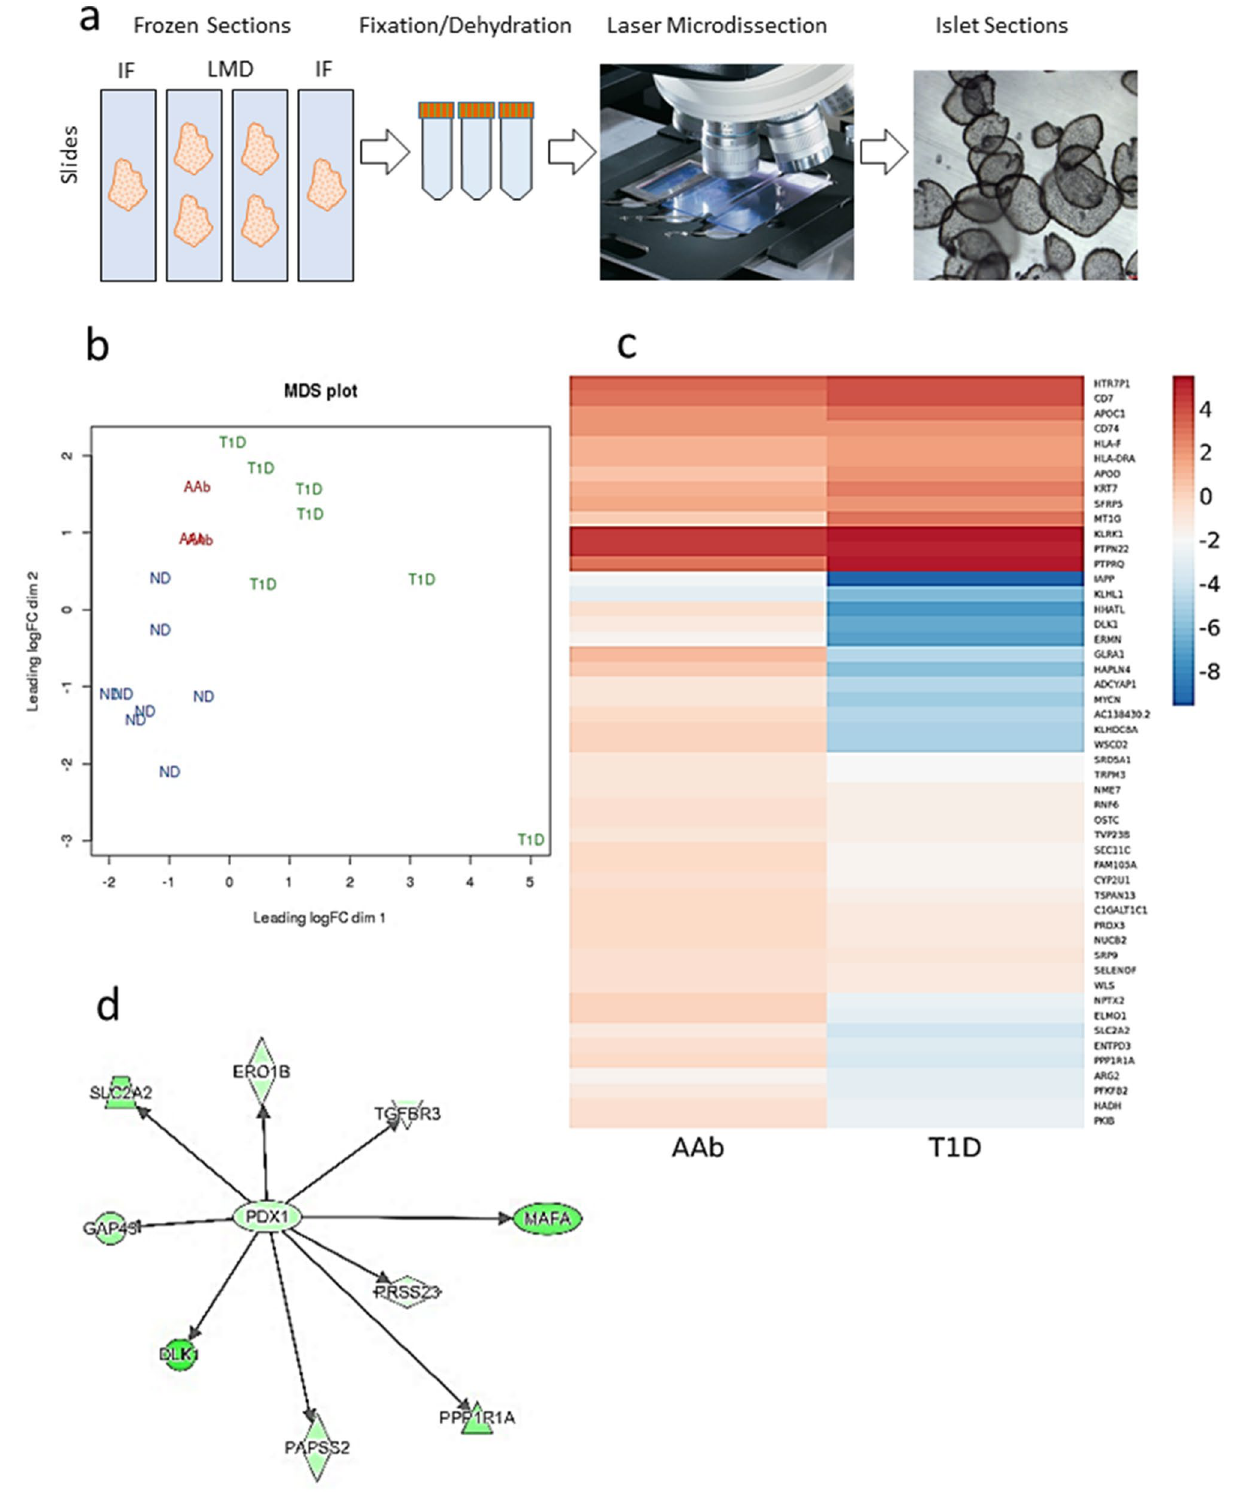
Figure 6. Laser microdissection assay pipeline and RNAseq analysis. ( a ) Experimental RNA-seq pipeline. Fresh frozen pancreas sections were placed onto slides and following fixation and dehydration, islets were microdissected using a Leica LMD7000 microscope. Microdissected islets were visualized in the microvial cap (far right). ( b ) Multi-dimensional scaling (MDS) plot shows grouping of donors within groups (n = 8 ND, n = 3 AAb, n = 7 T1D). One T1D donor (lower right) was not excluded though appearing as an outlier due to additional QC (see Supplementary Fig. S4). ( c ) Heatmap of top 50 differentially expressed genes between AAb versus ND (AAb) and T1D versus ND (T1D) (blue, down-regulated; red, upregulated). ( d ) Network interaction plot shows the transcription factor PDX-1 with other gene interactions including SLC2A2 ( GLUT2 ), MAFA and TGFBR3 (green, down regulated; red, upregulated). See Supplementary Tables 4–5 for gene